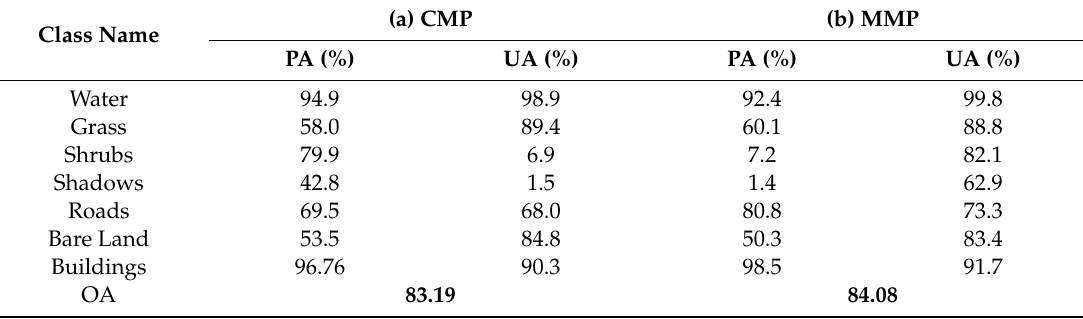
Table 7. The (a) CMP and (b) MMP classification accuracy results over